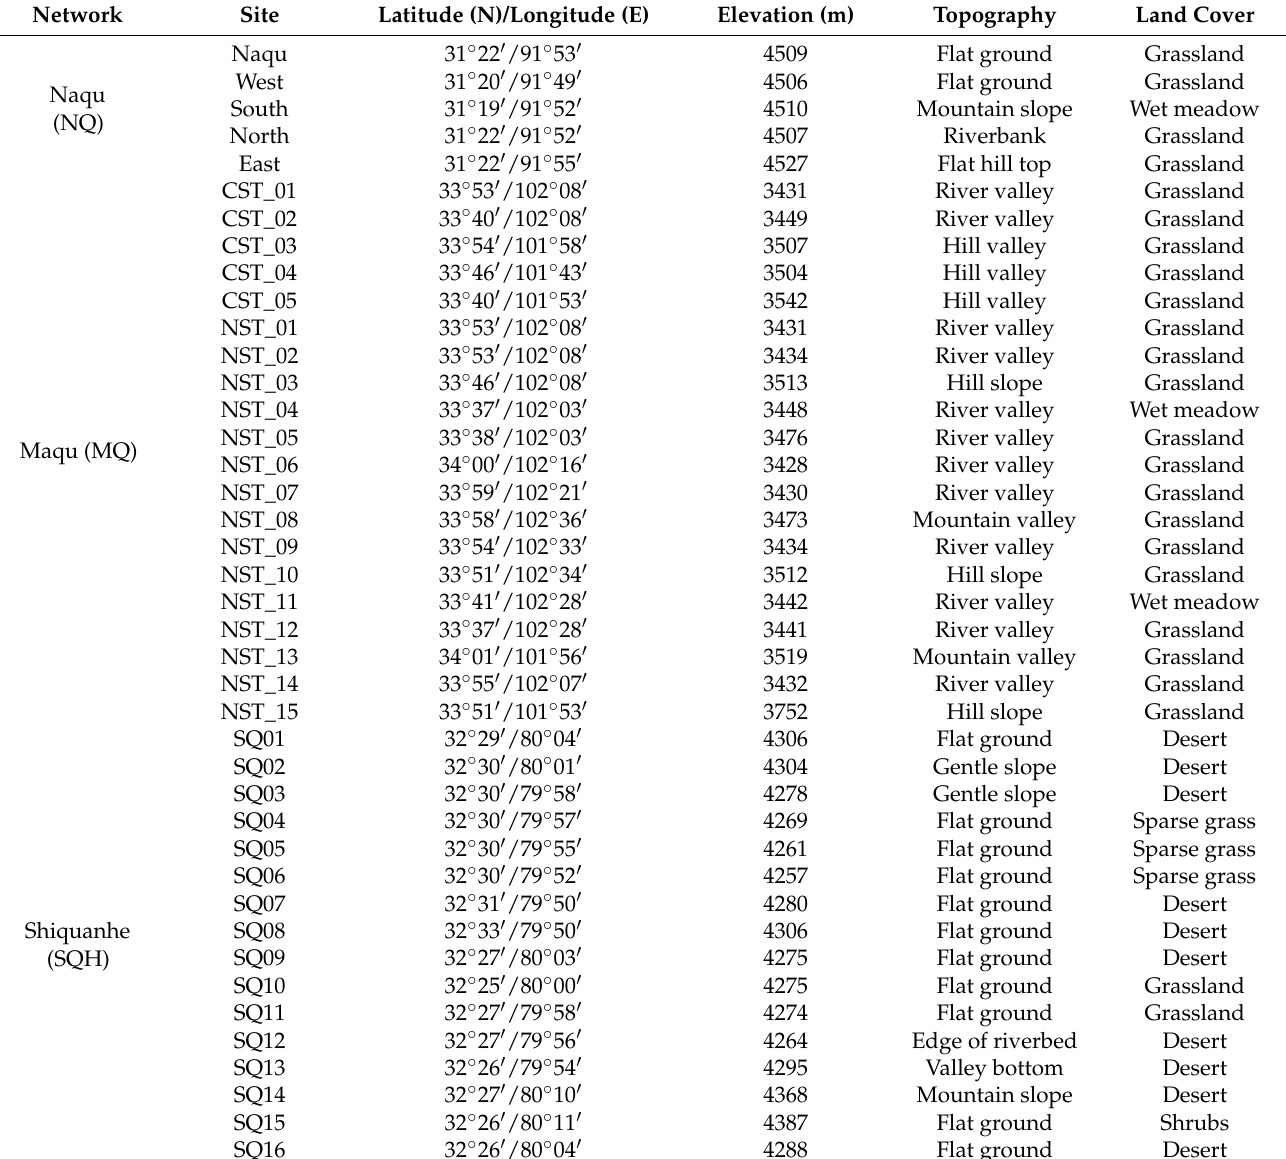
Table 1. Descriptions of the SM observation sites forming the three networks of NQ, MQ, and SQH on the